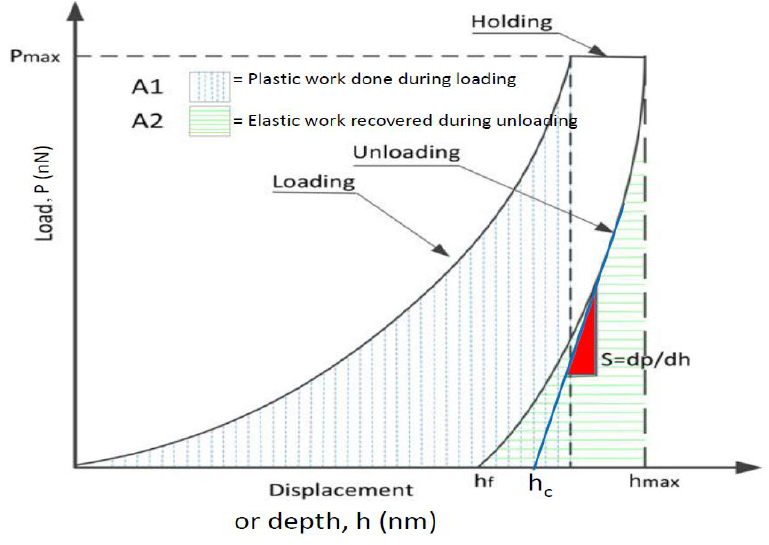
Figure 3. The evolution of the nanoindentation test, showing a typical load–displacement curve and loading–unloading cycle.